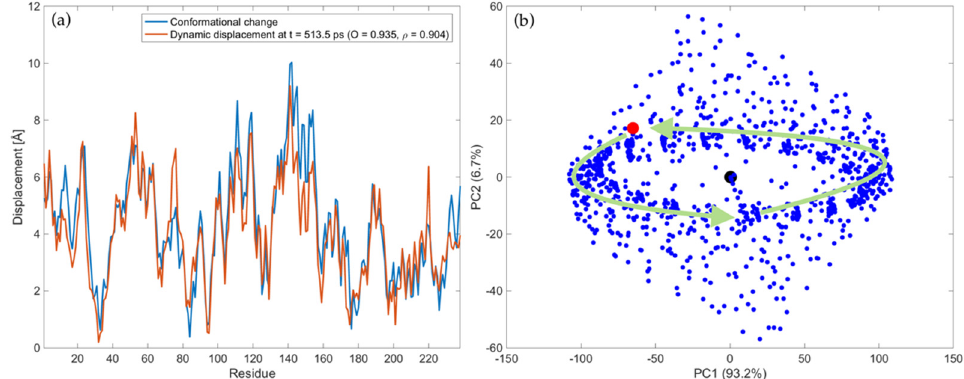
Figure 3. Trajectory of LAO-binding protein upon harmonic perturbations to the open form, with f F = 0.05 THz, ξ = 0.01 and force pattern depicted in Figure 2a: ( a ) Comparison between the displacements of the experimental conformational change (blue line) and dynamic displacements evaluated at t = 513.5 ps (orange line); ( b ) PC score plot of all conformations. The blue points represent the ensemble of generated conformations, whereas the black and red point represent the open (pdb: 2lao) and closed (pdb: 1lst) conformation, respectively. The green arrows are associated with the trajectory in the steady-state regime. A scale factor of 0.35 has been applied to the force pattern in order to have comparable values of absolute displacements. See Supplementary Movies S1 and S2 for more details about the protein trajectory in the coordinate and PC space, respectively.